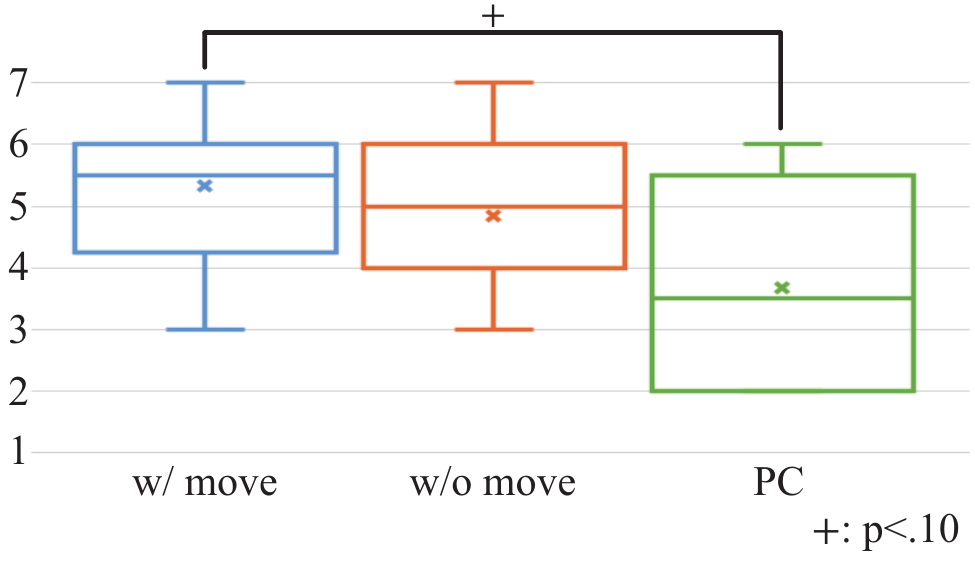
Figure 3. Results (“Did you feel that you actually walked through the shopping district?”)